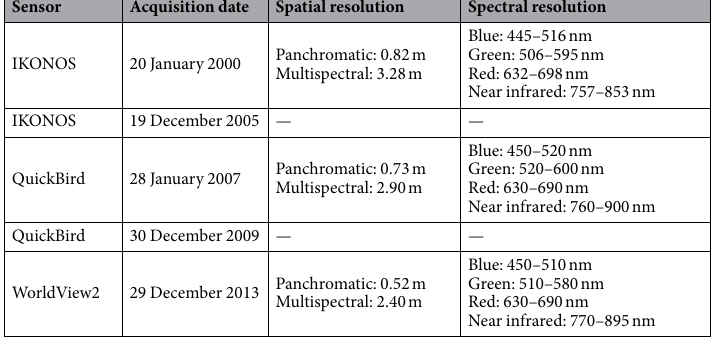
Table 1. Satellite imagery information.